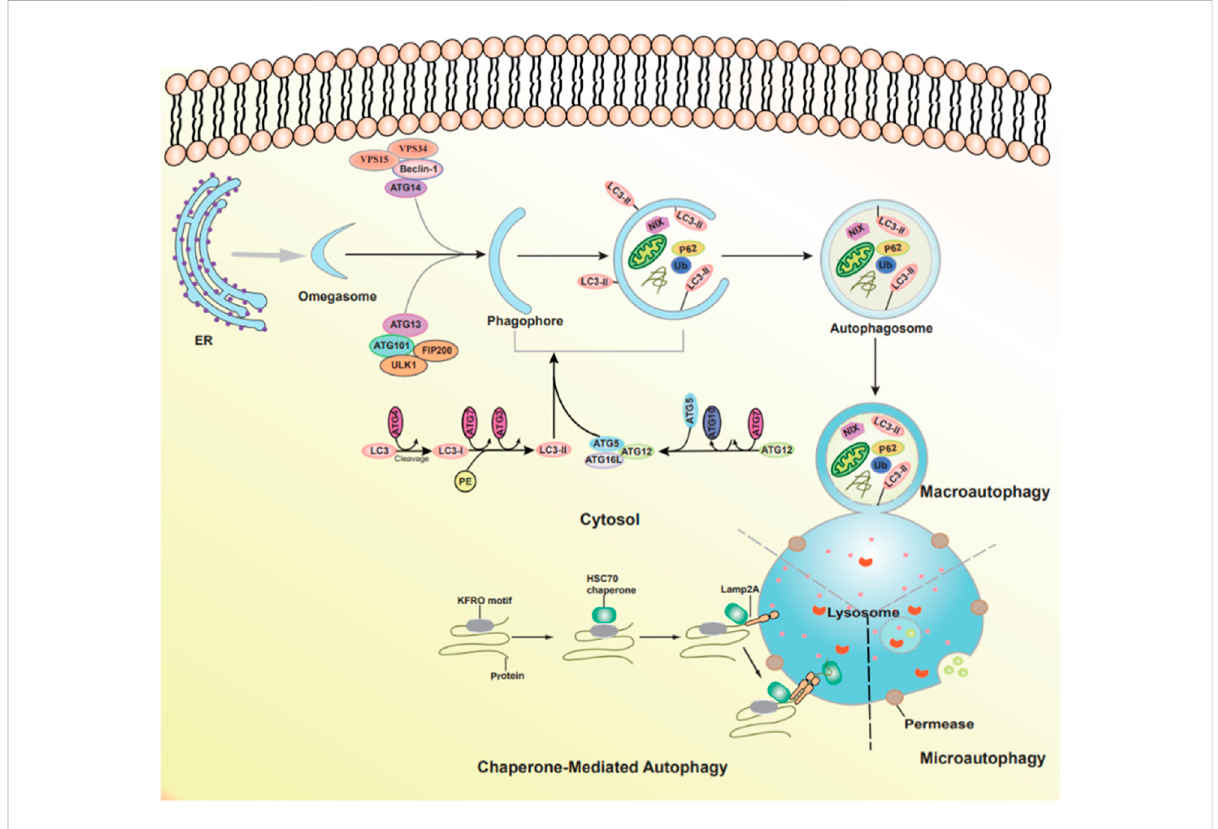
FIGURE 1 The types of autophagy and autophagic pathways. Three forms of autophagy can be identi fi ed: macroautophagy, microautophagy, and chaperone-mediated